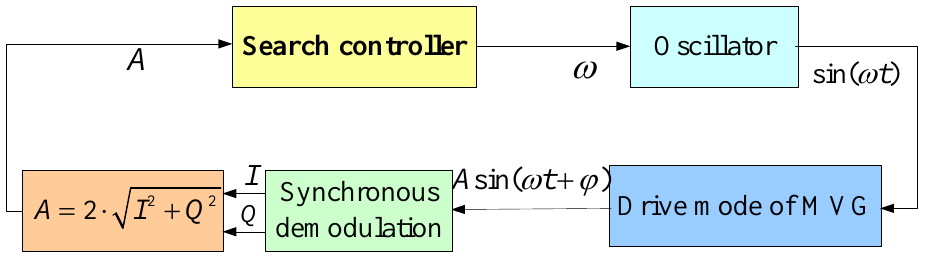
Figure 4. The principle diagram of the synchronous demodulation